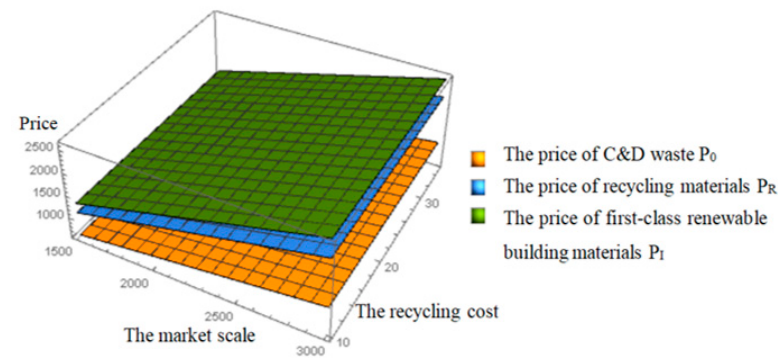
Figure 5. Effects of the market scale and the recycling cost on the prices.